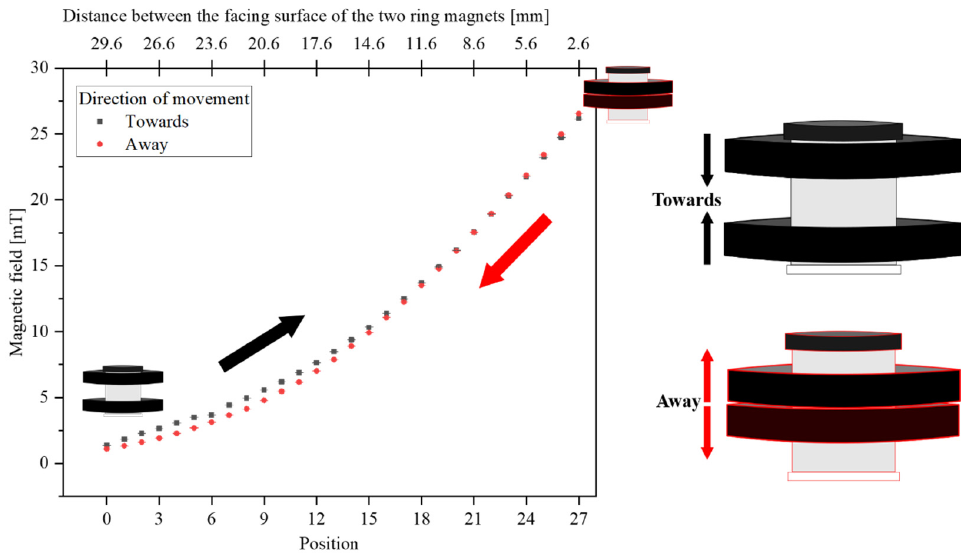
Figure 4. The dynamic applicable static magnetic field through PMOM. The magnetic fields were measured in 28 steps by moving the two permanent ring magnets towards each other (black squares following the black arrow), thus increasing the magnetic field, and then pulling them away from each other to decrease the field (red circles following red arrow).